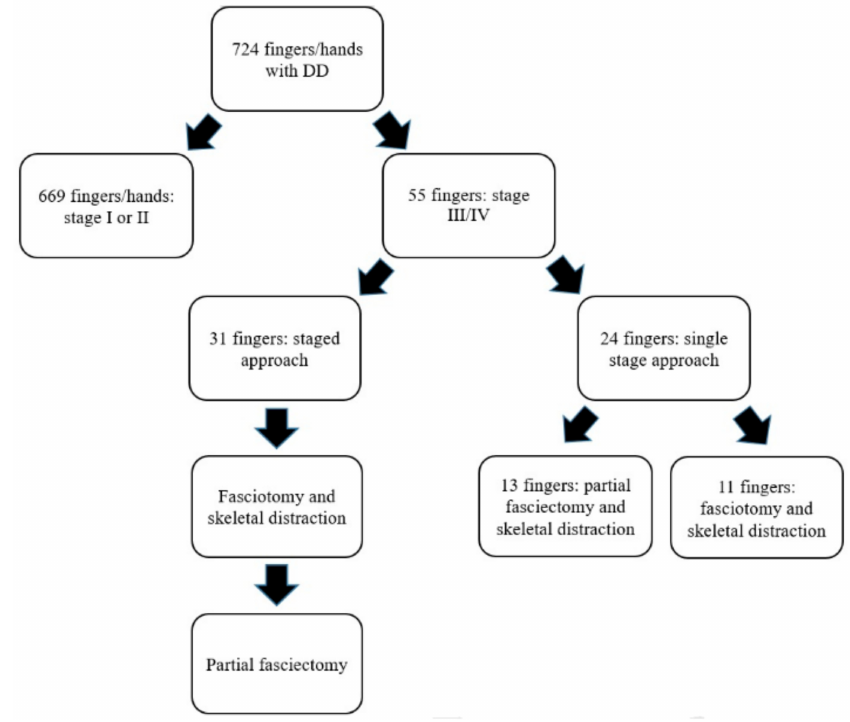
Figure 4. Individualized treatment regimen of DD.